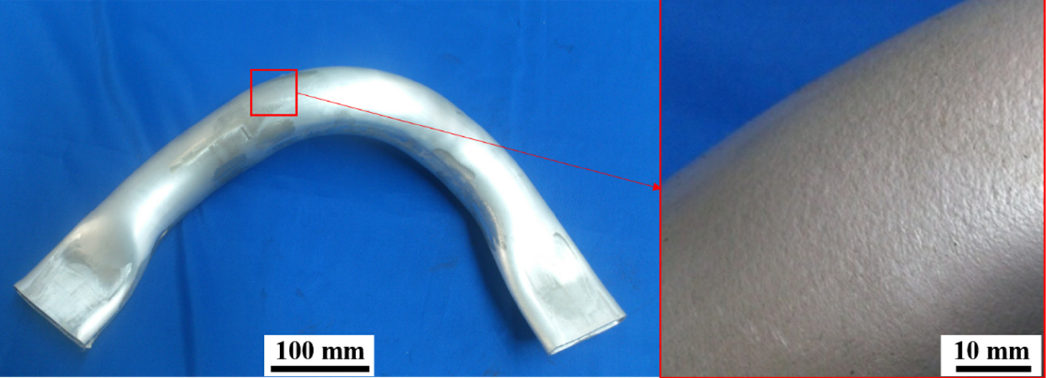
Figure 1. Aluminum alloy structural member and “orange ‐ peel” defects.